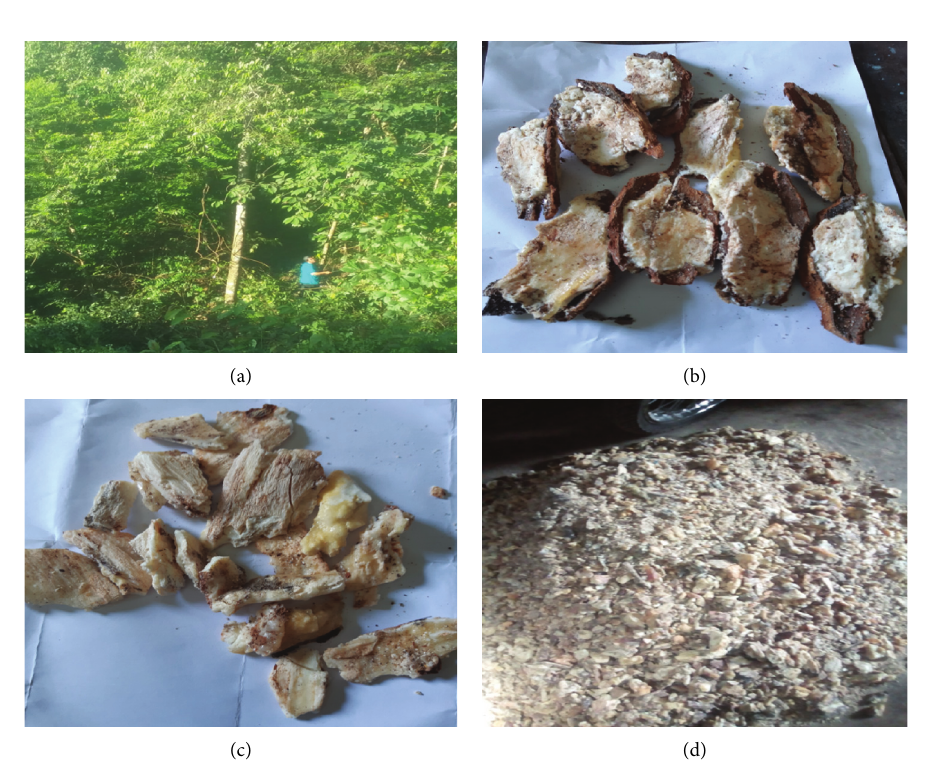
Figure 1: A selected mother tree of Styrax benzoin and raw frankincense sap used for the isolation of cinnamic acid: (a) good quality sap producing mother tree, (b) tapped frankincense sap attached to the bark, (c) crystal super-quality frankincense sap, and (d) raw frankincense powder material used for isolation of cinnamic acid. Table 2: Physical and chemical properties of cinnamic acid isolated from frankincense sap samples. Description of frankincense